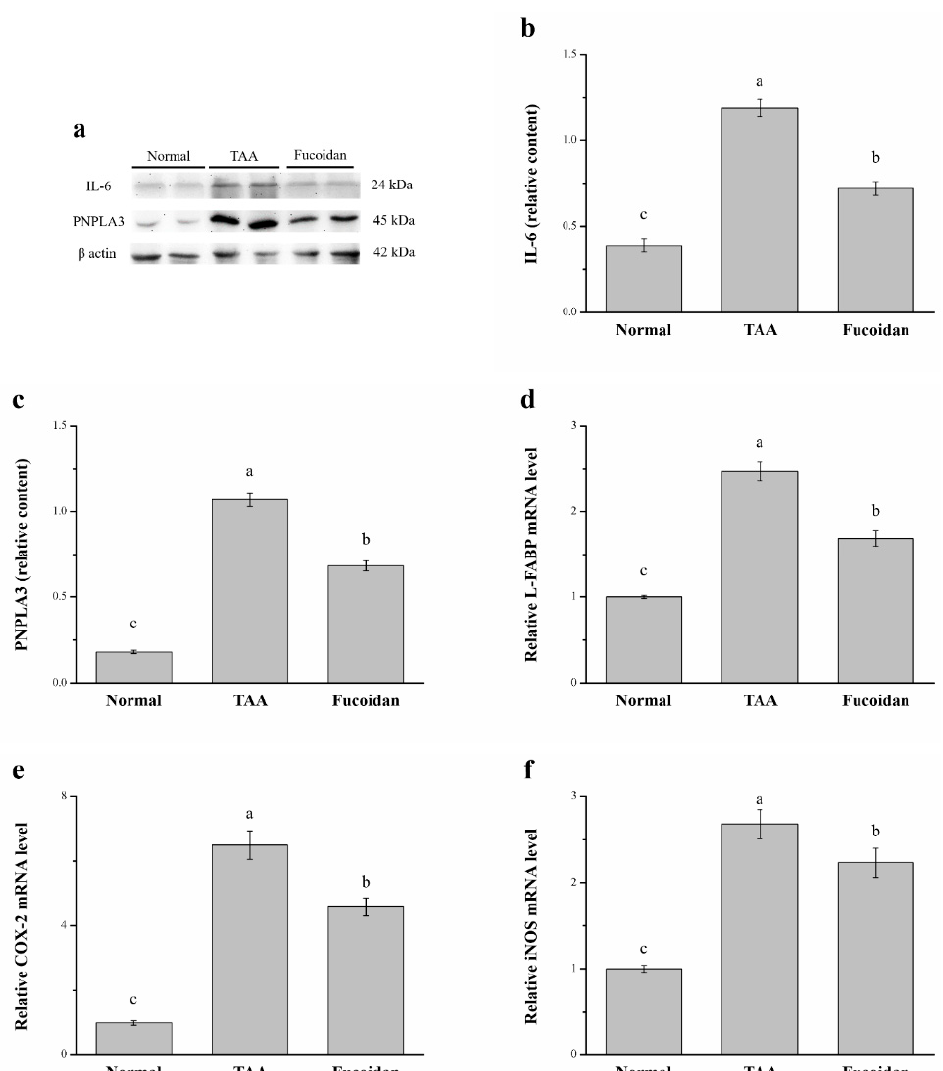
Figure 6. ( a ) Representative Western blot of the liver extracts for interleukin-6 (IL-6) and patatin- like phospholipid domain containing protein 3 (PNPLA3) expression, ( b ) IL-6, and ( c ) PNPLA3 expression, as well as changes in the ( d ) liver fatty acid-binding protein (L-FABP), ( e ) cyclooxygenase- 2 (COX-2), and ( f ) inducible nitric oxide synthase (iNOS) mRNA levels in the livers of normal mice, TAA-induced liver injury mice, and fucoidan-treated TAA-induced liver injury mice over a time period of 42 days. All data are presented as the means ± SEMs ( n = 10). a–c Data with different letters in the columns are significantly different with one-way ANOVA, and the means of different groups were compared by Duncan’s test at p < 0.05.